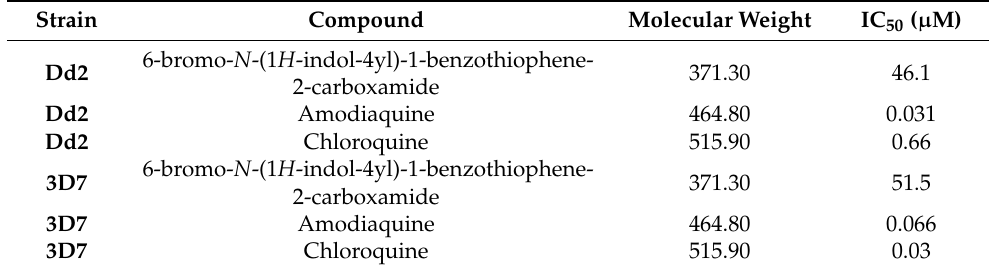
Table 1. Determination of IC 50 values using a SYBR Green 1(SG)-based in vitro method. Strain Compound Molecular